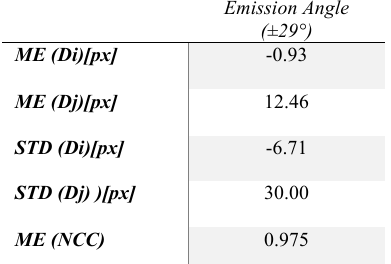
Table 2: STC matching